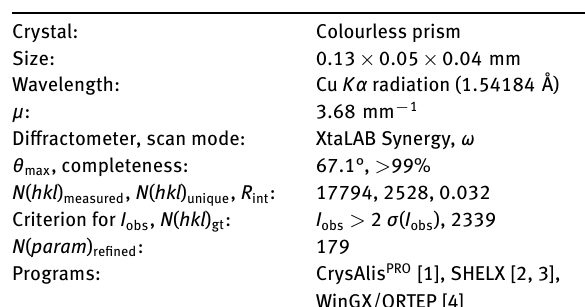
Table 1 contains crystallographic data and Table 2 con- tains the list of the atoms including atomic coordinates and displacement parameters.